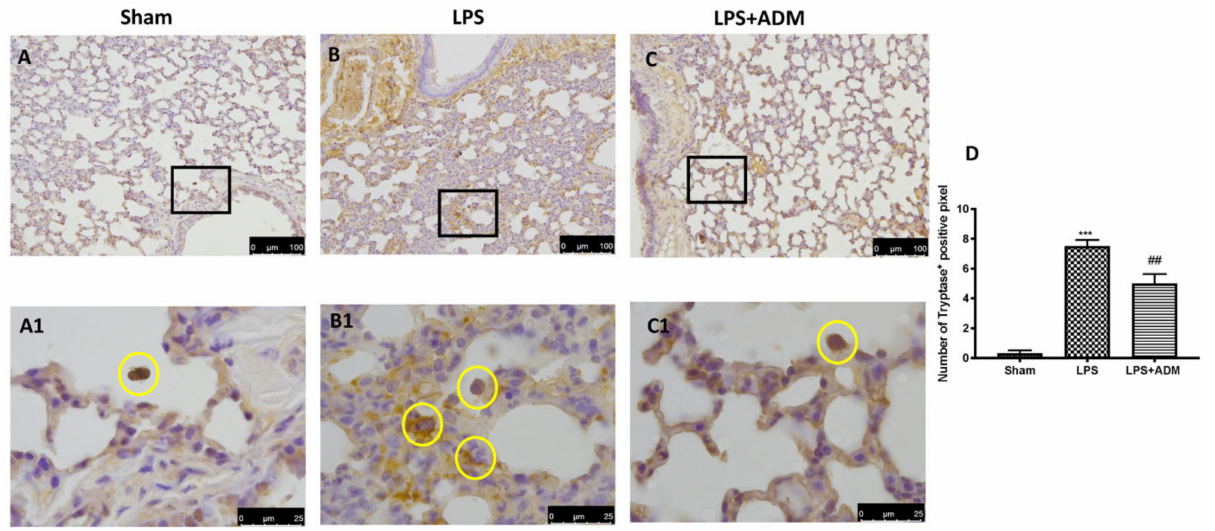
Figure 5. Immunohistochemical analysis for tryptase: Sham ( A , A1 ), LPS ( B , B1 ), LPS + ADM 2% ( C , C1 ), graphical quantification ( D ). A 20 × and 100 × magnification is shown. Data are expressed as the mean ± SEM of N = 6 mice/group. *** p < 0.001 vs. sham; ## p < 0.01 vs. LPS.